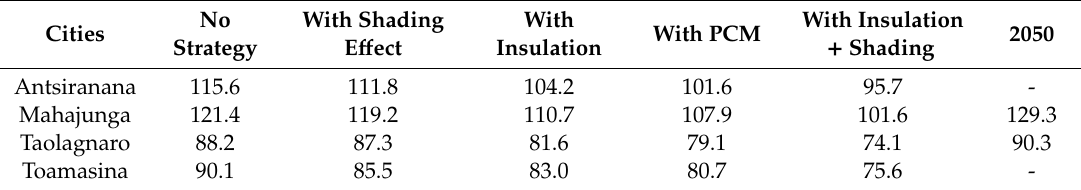
Table 5. Electricity consumption (kWh / m 2